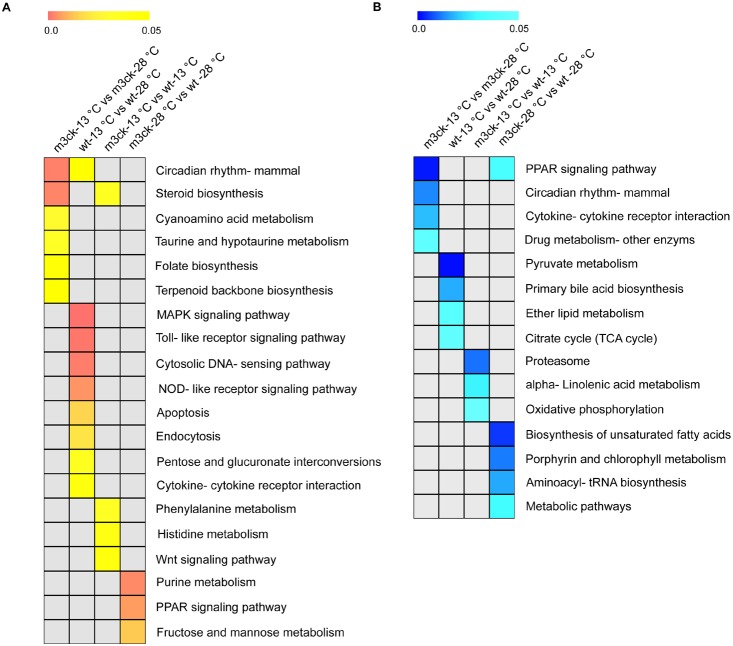
KEGG pathway analysis of cold-regulated genes.A. Up-regulated genes. B. Down-regulated genes. Up- and down-regulated genes were submitted for KEGG enrichment analysis using the SAS online analysis system. Color scales represent P values of enrichment tests and gray cells indicate an empty value or P>0.05.